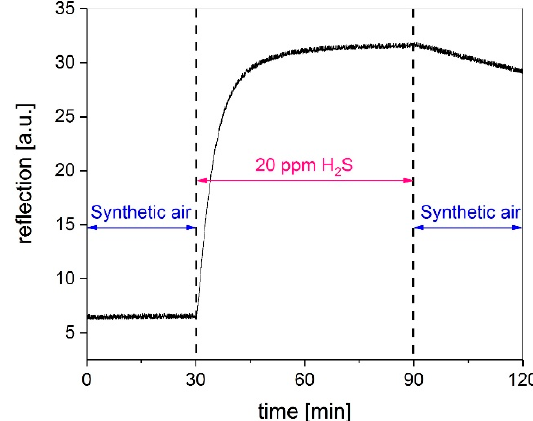
Figure 3. Reflection measurement of the Cu-PAN complex on silica powder at 550 nm over the measurement period. Before and after gas exposure of H 2 S for 60 min, the gas measurement chamber was flushed with synthetic air for 30 min, respectively. The measurement was performed in synthetic air at a relative humidity of 40% at room temperature.